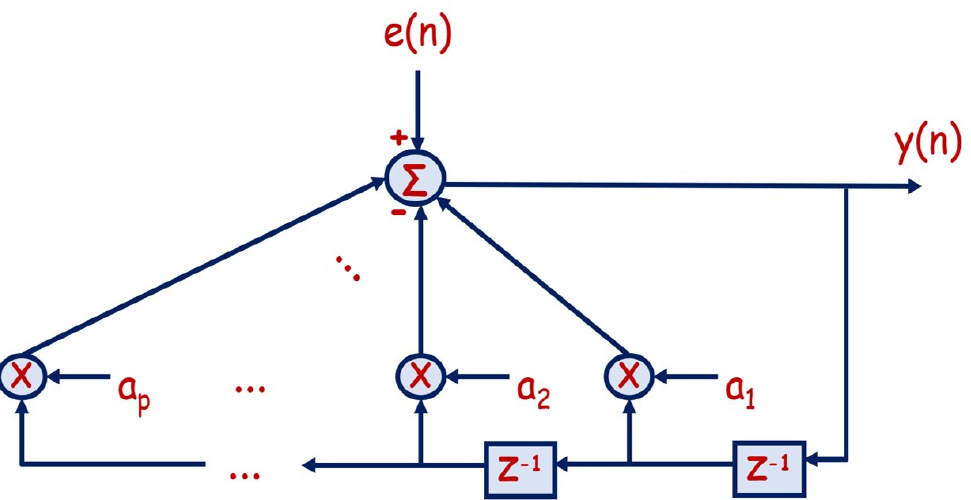
Figure 2. The hardware realization of autoregressive model AR ( p ) where Z − 1 is the time shift (delay) operator; y ( n ) is the target model signal to be described and predicted by AR model; e ( n ) is a prediction noise (error); and a 1 , a 2 , . . . , a p are polynomial coefficients for AR model which are derived according to the model order.